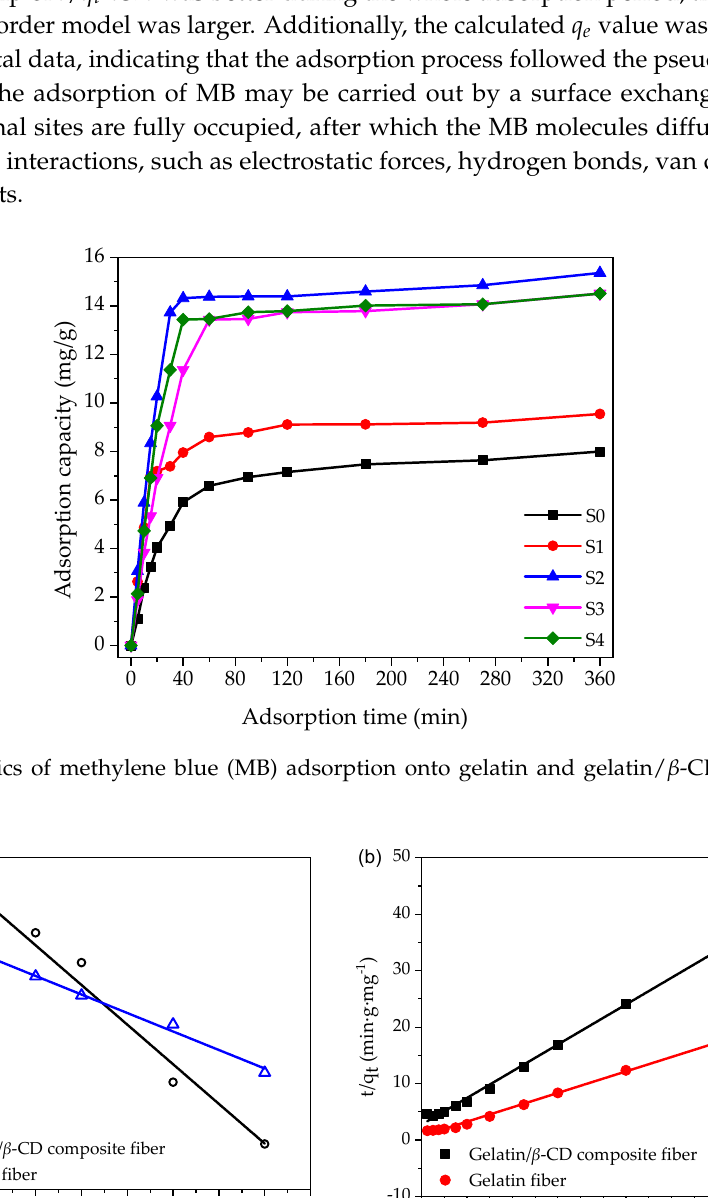
Figure 5. Adsorption kinetics of MB onto the gelatin and gelatin/ β -CD composite fiber adsorbents based on the pseudo-first-order ( a ) and pseudo-second-order ( b ) kinetic model. Table 1. Kinetic parameters describing the adsorption of MB onto the gelatin and gelatin/ β -CD composite fiber adsorbents based on the pseudo-first-order and pseudo-second-order kinetic models. Adsorbent